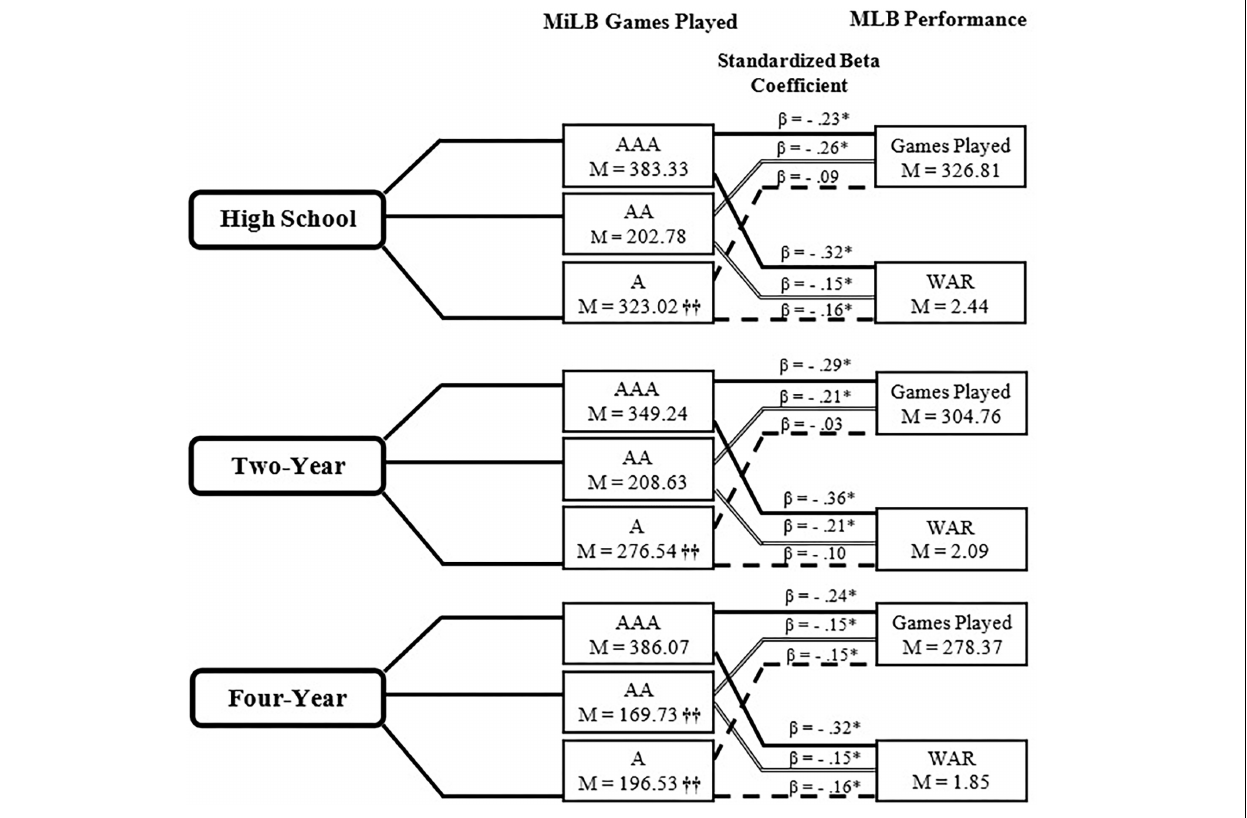
FIGURE 2 | Relationship between Minor League career and MLB performance- Position Players. WAR, Wins Above Replacement. †† Significant difference ( p < 0.05) from two other institutions at that level. β Signifies standardized beta coefficient from regression model with A, AA, AAA Games Played used as predictors of Major League Baseball Games Played and Wins Above Replacement; ∗ p <